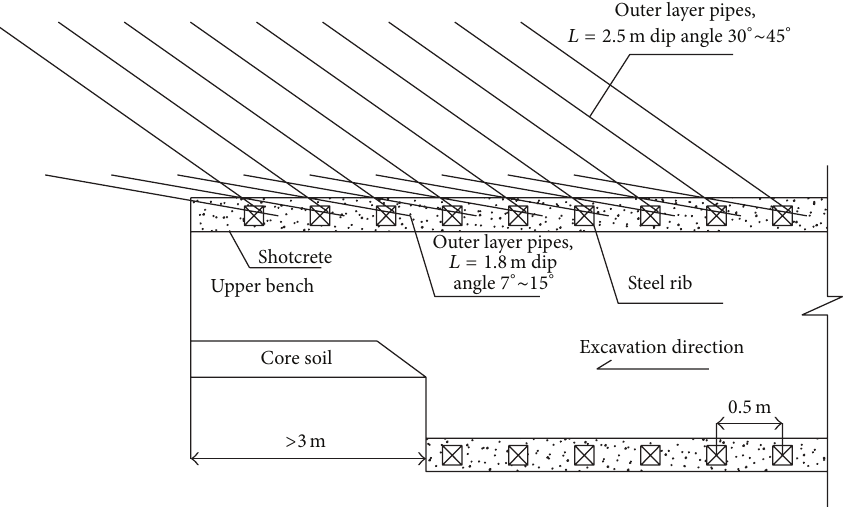
Figure 16: Double-layer grouting